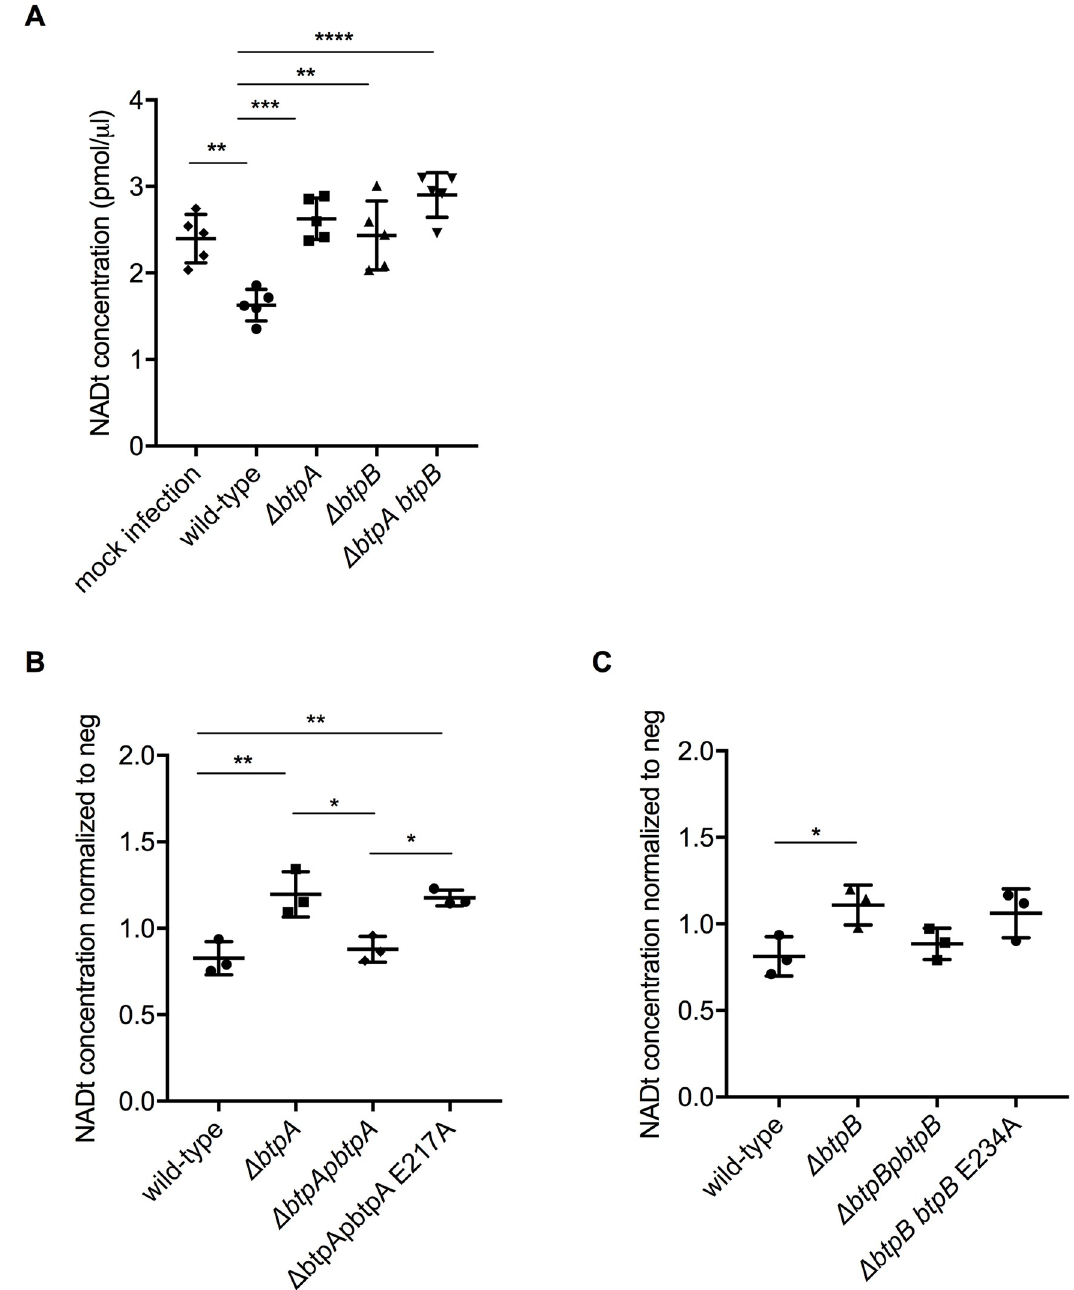
Fig 9. B . abortus TIR domain-containing proteins control intracellular total NAD levels during infection of cultured epithelial cells. (A) HeLa cells were infected for 48 h with either wild-type B . abortus , or strains lacking btpA , btpB or both genes. Mock infected cells are also included. Total NAD levels were measured using a colorimetric assay and data correspond to means ± standard deviation from five independent experiments and statistical comparison was done with a one-way ANOVA test, with statistical significance indicated in the graph. Between mock and wild-type p = 0.0028 ( �� ); between the wild-type and btpA , btpB or btpAbtpB mutans p = 0.0002 ( ��� ), 0.0018 ( �� ) and < 0.0001 ( ���� ), respectively. Higher NAD levels in the infected cells than in the mock experiment are likely attributable to the fact that intracellular NAD levels from bacterial cells are added up to those of the cell line. (B) HeLa cells were infected for 48 h with either wild-type B . abortus , a Δ btpA mutant, the complemented strain Δ btpA p btpA and a Δ btpA complemented with a catalytic mutant Δ btpA p btpA E217A. Results are normalized to mock infected cell values and correspond to means ± standard deviation from three independent experiments and statistical comparison was done with a one-way ANOVA test, with statistical significance indicated in the graph. For wild-type versus Δ btpA p = 0.0052, Δ btpA versus